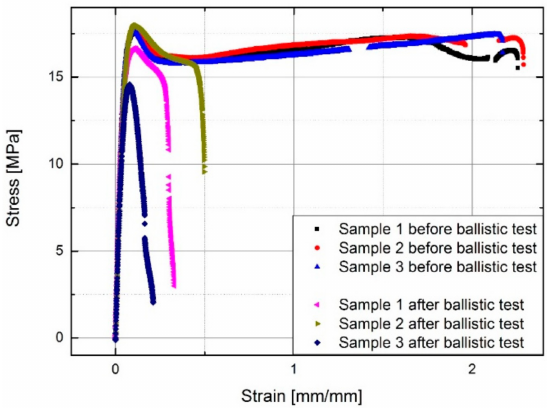
Figure 8. Tensile tests on samples before and 9 mm caliber ballistic